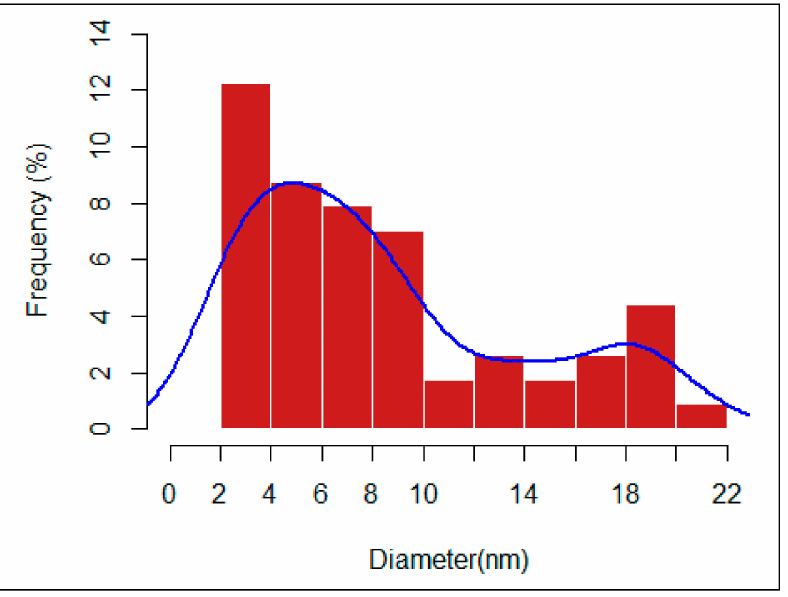
Figure 5. The size distribution of AgNPs produced under incubation in process B with 1 mM AgNO 3 and calculated by measuring the diameters of 63 silver nanoparticles in the TEM